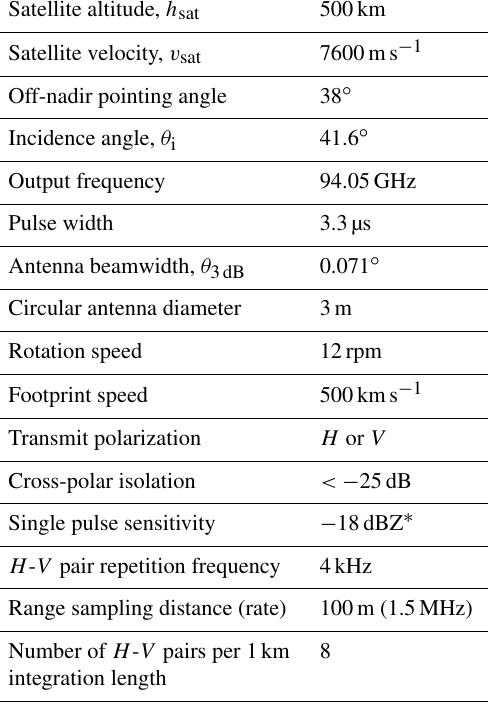
Table 3. Specifics of the radar for the simulation. The configura- tion adopted here is the one proposed for WIVERN in a recent ESA Earth Explorer 11 call. The E2E simulator can study various trade- offs to optimize mission, system, and instrument parameters.